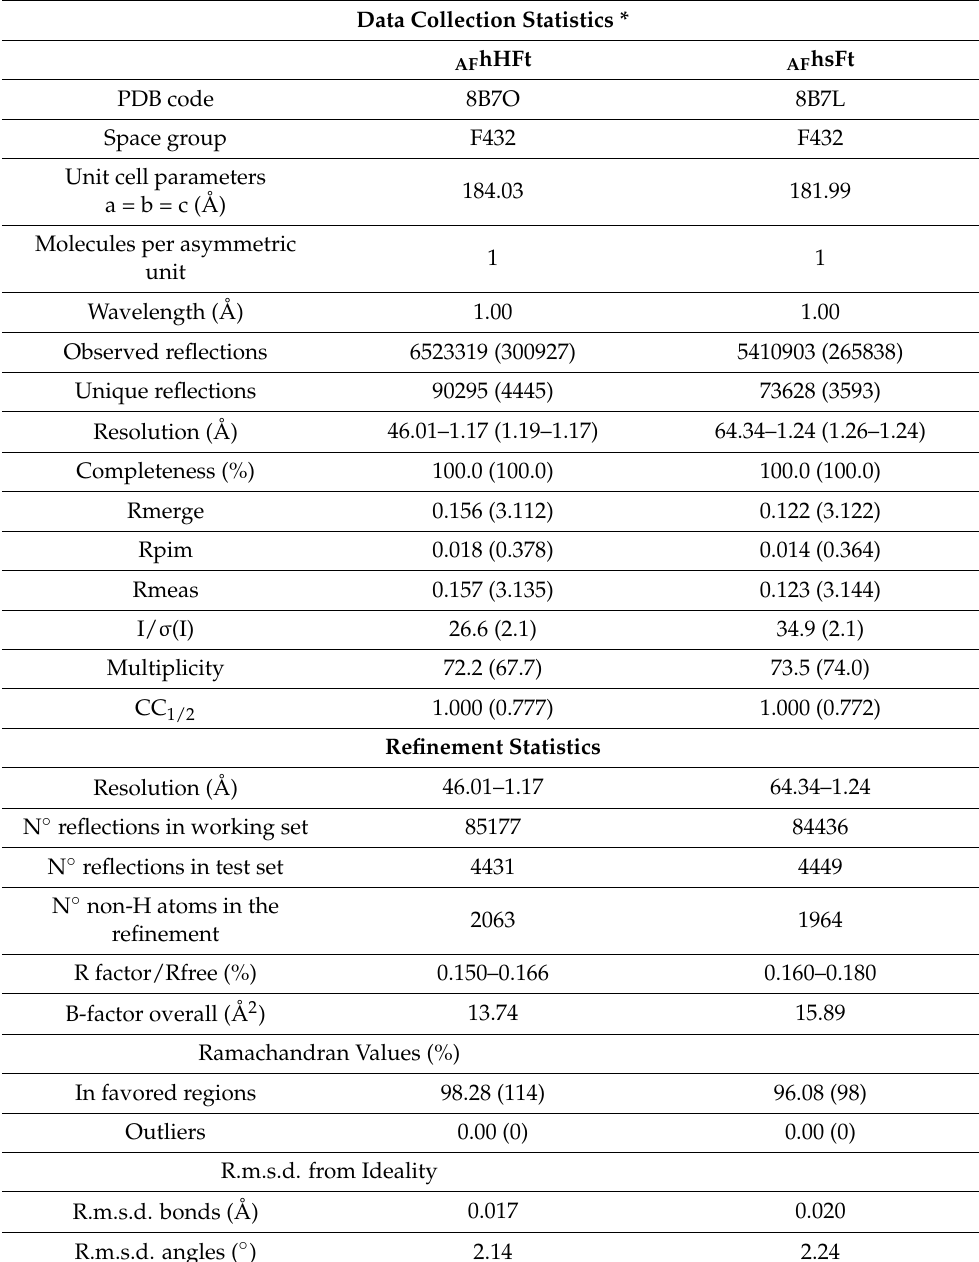
Table 1. Data collection and refinement statistics for AF-encapsulated